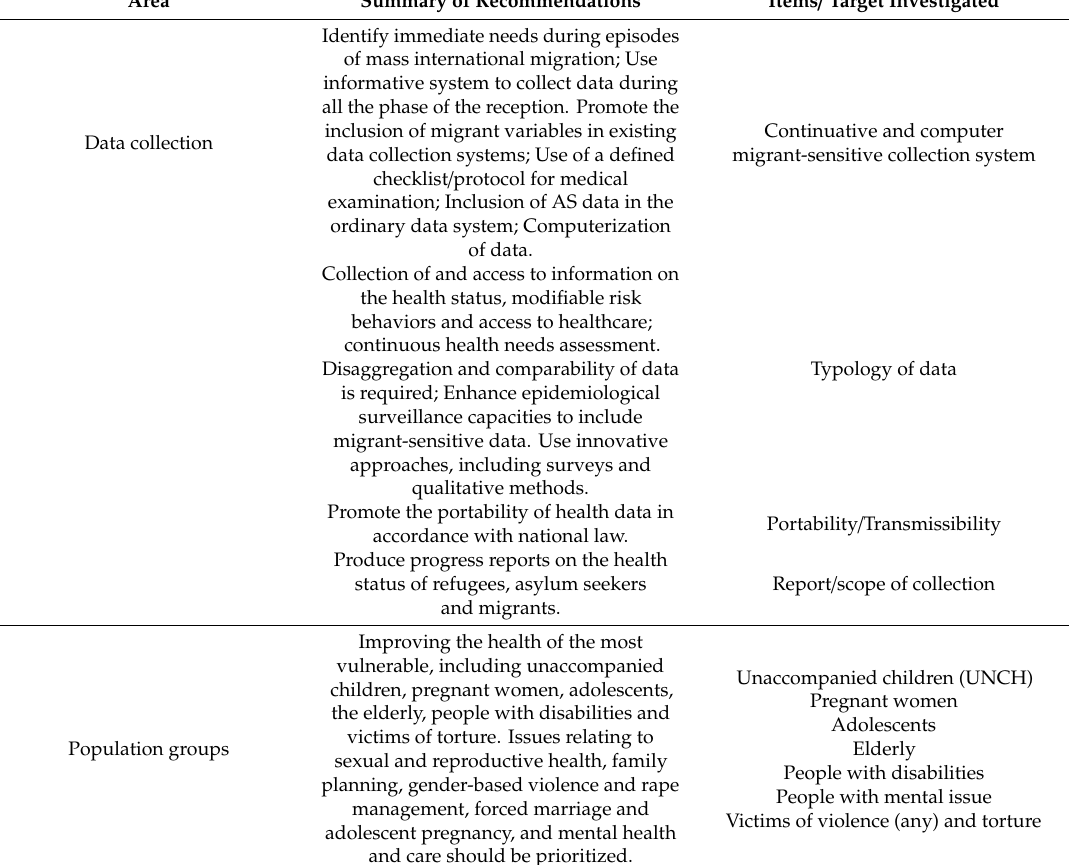
Table 1. Framework for Policy Content